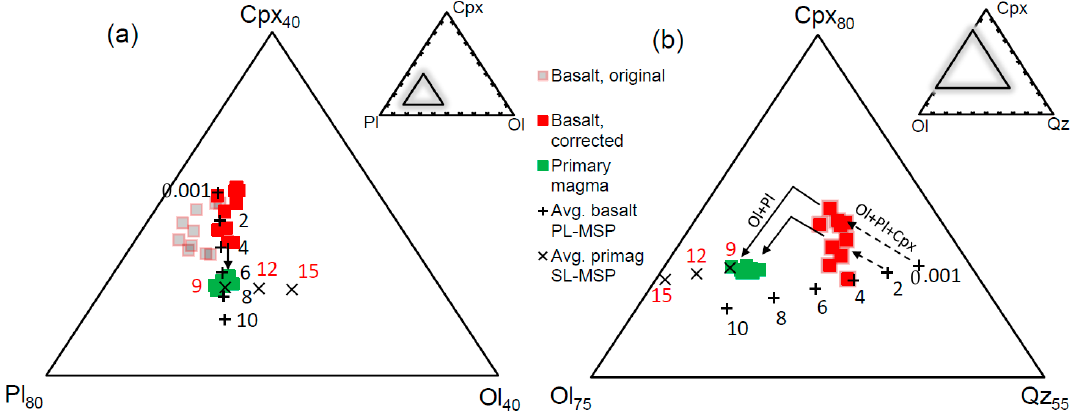
Figure 6. Portions of the pseudoternary projections of the basalt tetrahedron: ( a ) Ol-Pl-Cpx from Qz, and ( b ) Ol-Cpx-Qz from Pl (after [63,64]) showing the compositions of the Rajmahal Group I basalts and their corresponding melts (determined by subtracting plagioclase). For clarity, only the multiple saturation points for plagioclase lherzolite (PL-MSP at 1 bar and 2–10 kbar with 2 kbar intervals, after [59]) of the average basalt and spinel lherzolite (SL-MSP at 9–15 kbar with 3 kbar intervals, after [63]) of the average primary magma are shown. The solid lines with arrowheads represent examples of model reverse fractionation paths along the Ol + Pl + Cpx and Ol + Pl cotectic boundaries, and the dashed lines with arrowheads in ( b ) represent part of the inferred Ol + Pl + Cpx cotectic boundary at 1 bar and 2 kbar.